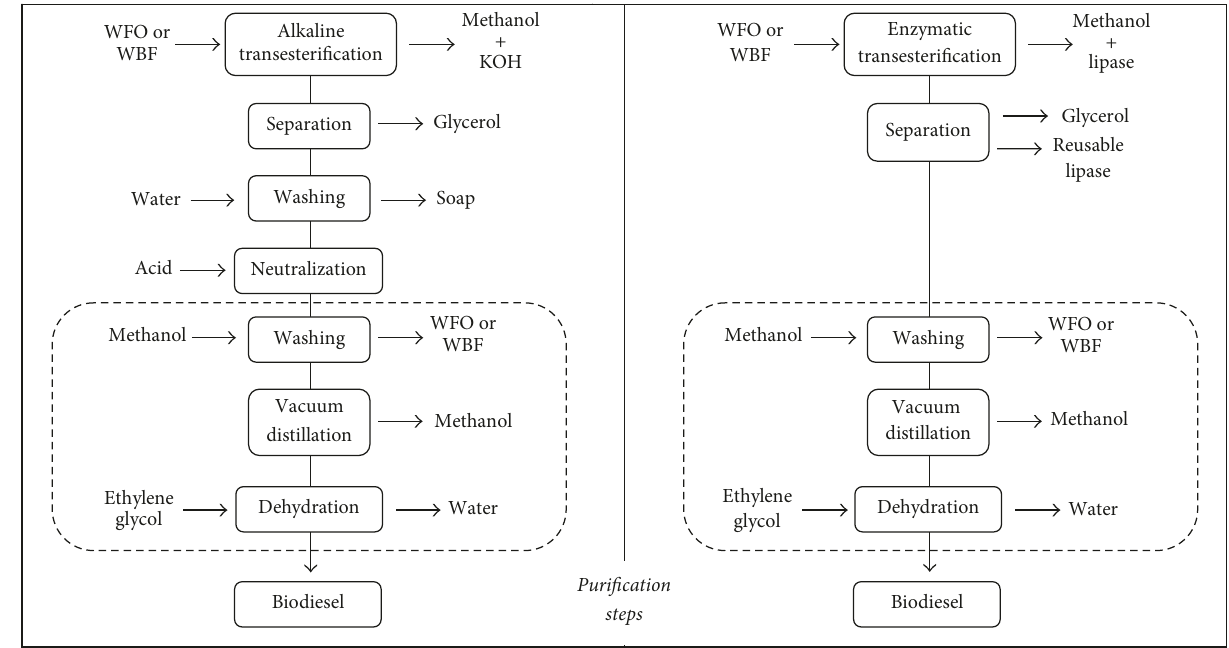
Figure 4: Simplified process flow chart of both alkaline and enzymatic catalyzed biodiesel production.